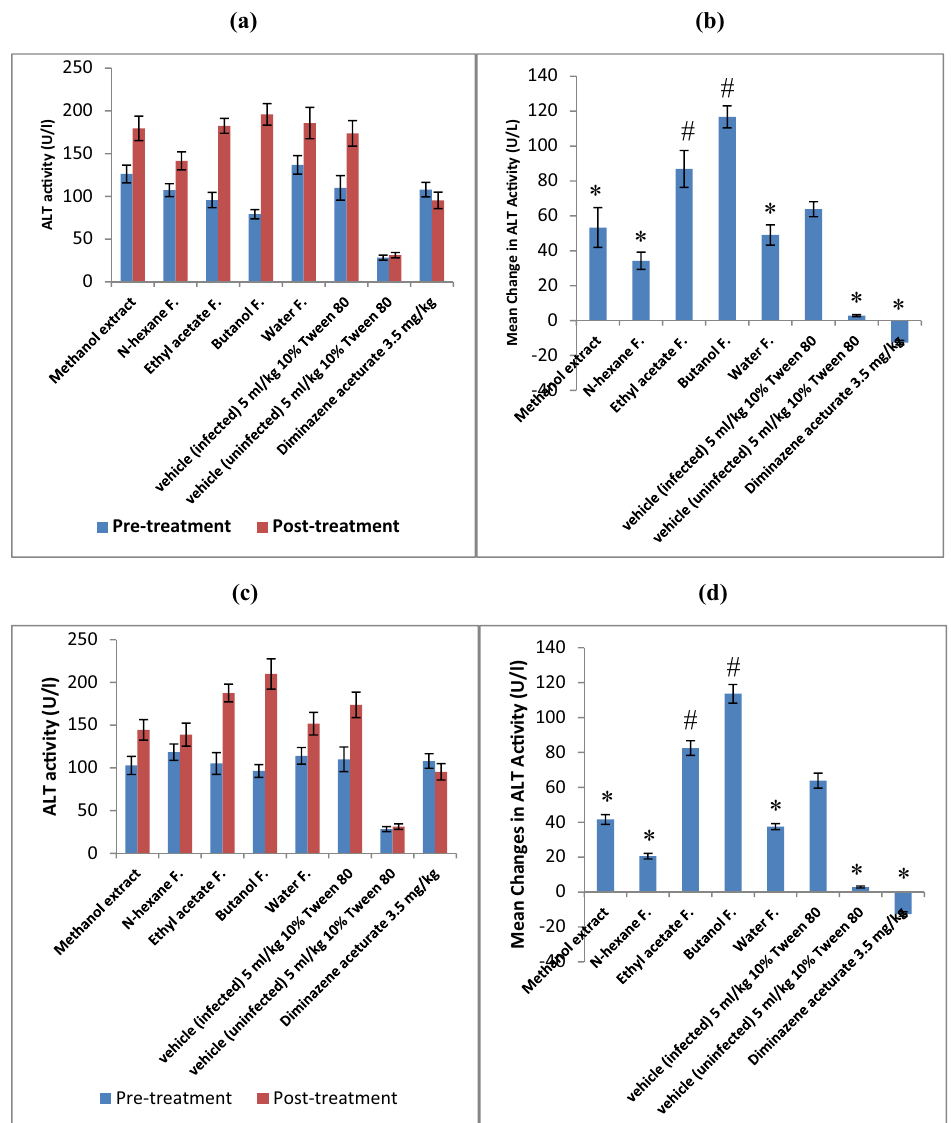
Figure 5: E ff ect of the extract and fractions on serum the ALT activity of T. brucei brucei - infected animals. ( a ) 200 mg/kg extract and fraction e ff ect on ALT activity; ( b ) 200 mg/kg extract and fraction e ff ect on mean changes in ALT activity; ( c ) 400 mg/kg extract and fraction e ff ect on ALT activity; and ( d ) 400 mg/kg extract and fraction e ff ect on mean changes in ALT activity. * P < 0.05 compared to the vehicle - infected control group ( signi fi cant decrease ) and # P < 0.05 compared to the vehicle - infected control group ( signi fi cant increase )